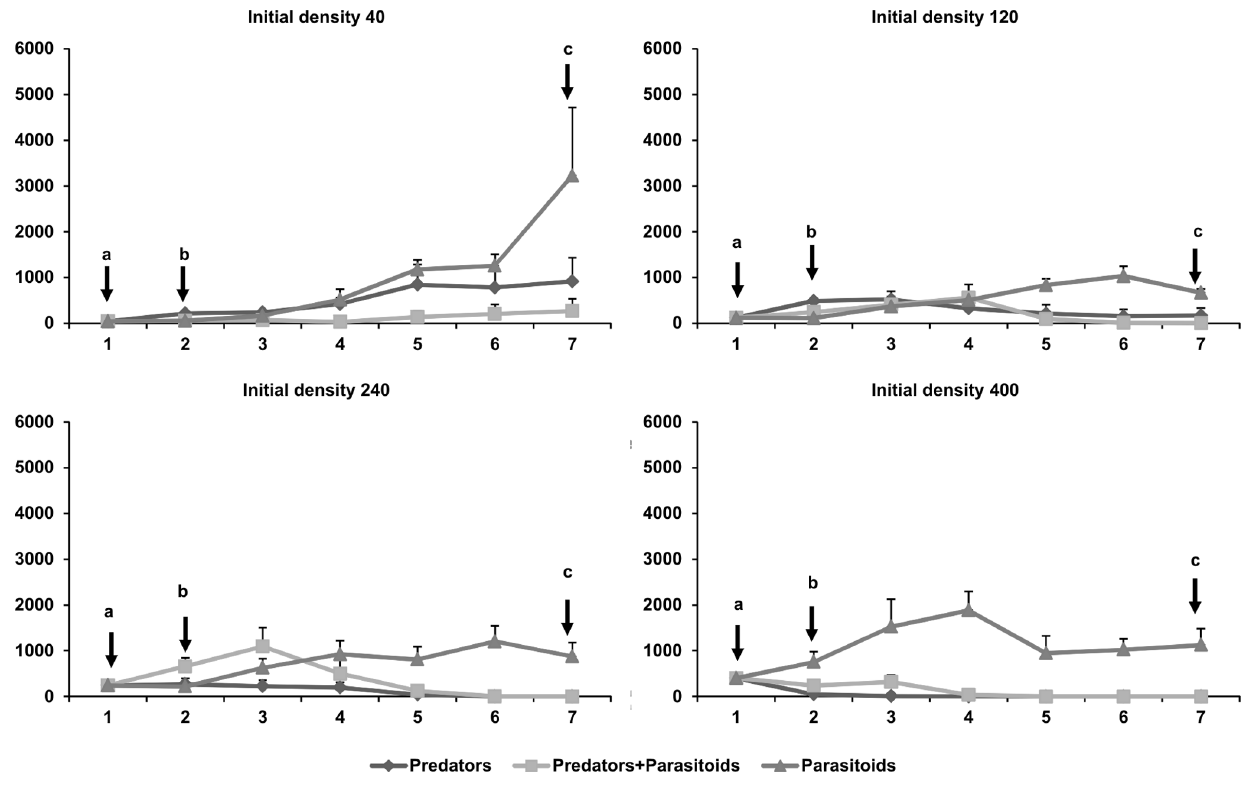
Figure 1. Average ( ± SE) numbers of aphids recorded in the different sub-treatments started with different initial numbers of aphids (40, 120, 240 and 400). Arrows indicate: a - first count, b - appearance of first larvae and mummies and c - final count.